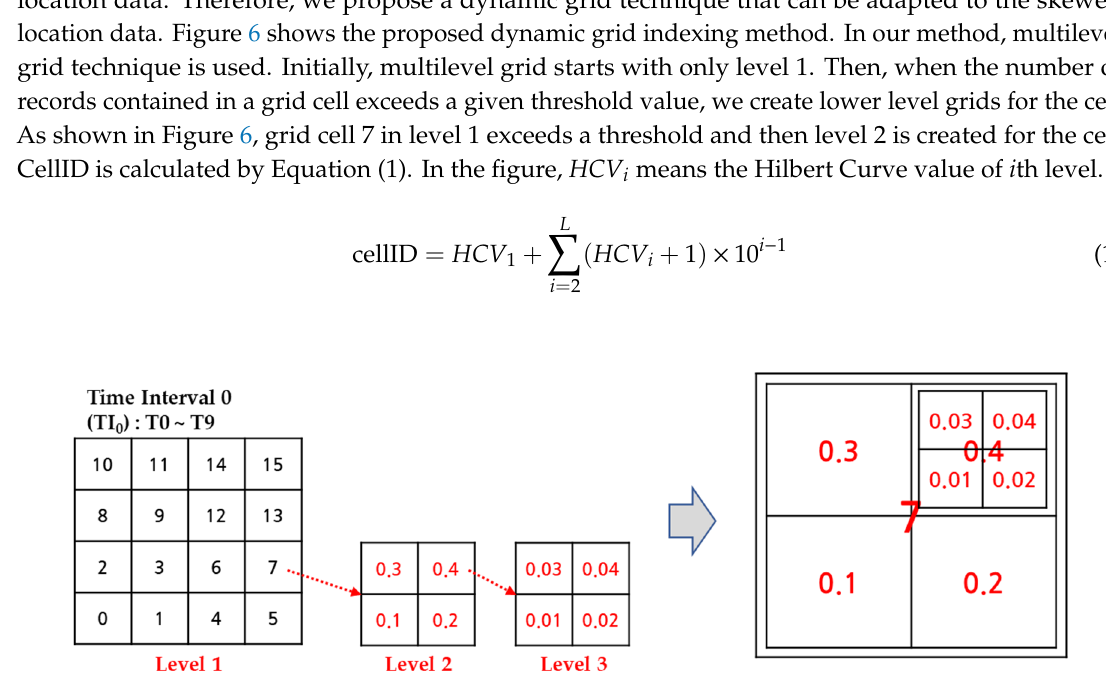
Figure 6. Dynamic grid indexing for skewed data.